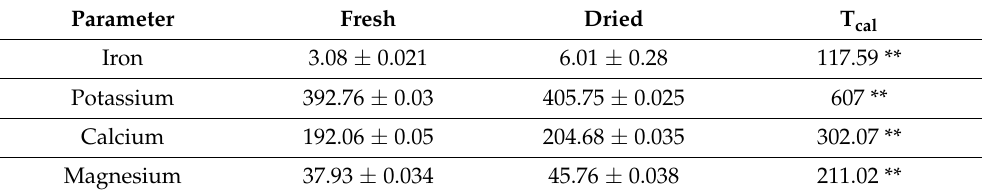
Table 2. Comparative analysis of mineral content of T. officinale leaves (mg/100 g). Parameter